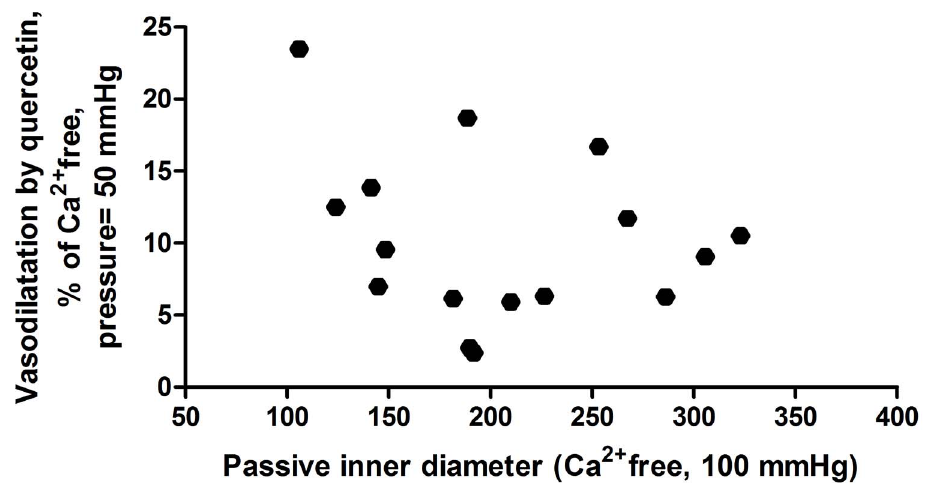
Figure 3. Quercetin induced dilatation as function of morphological lumen size. We found no correlation (p . 0.05 with Pearson’s correlation).